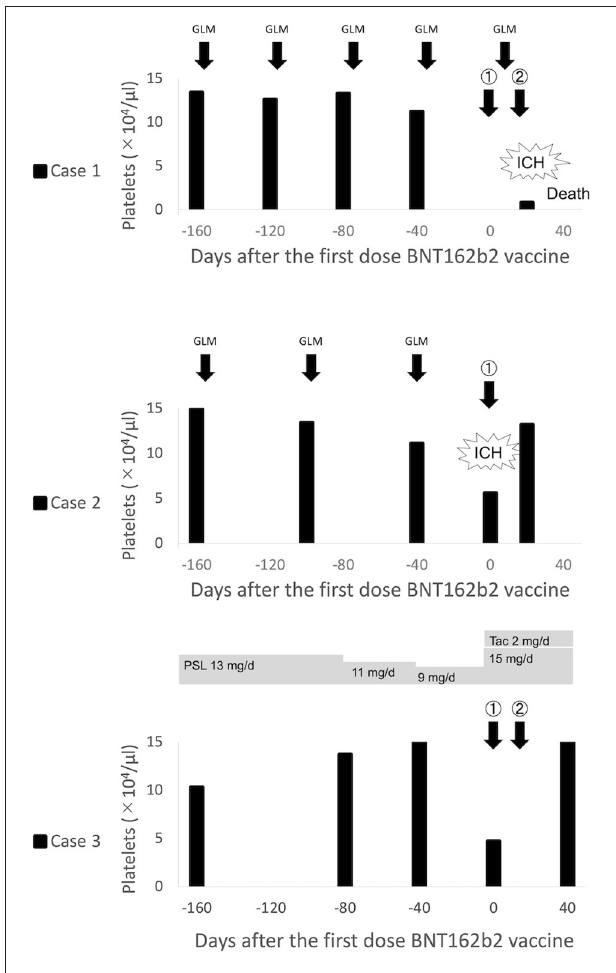
FIGURE 1 | Clinical course of thrombocytopenia in patients with rheumatoid arthritis after BNT162b2 vaccination. ICH, Intracranial hemorrhage; GLM, Golimumab; PSL, Prednisolone; Tac, Tacrolimus.